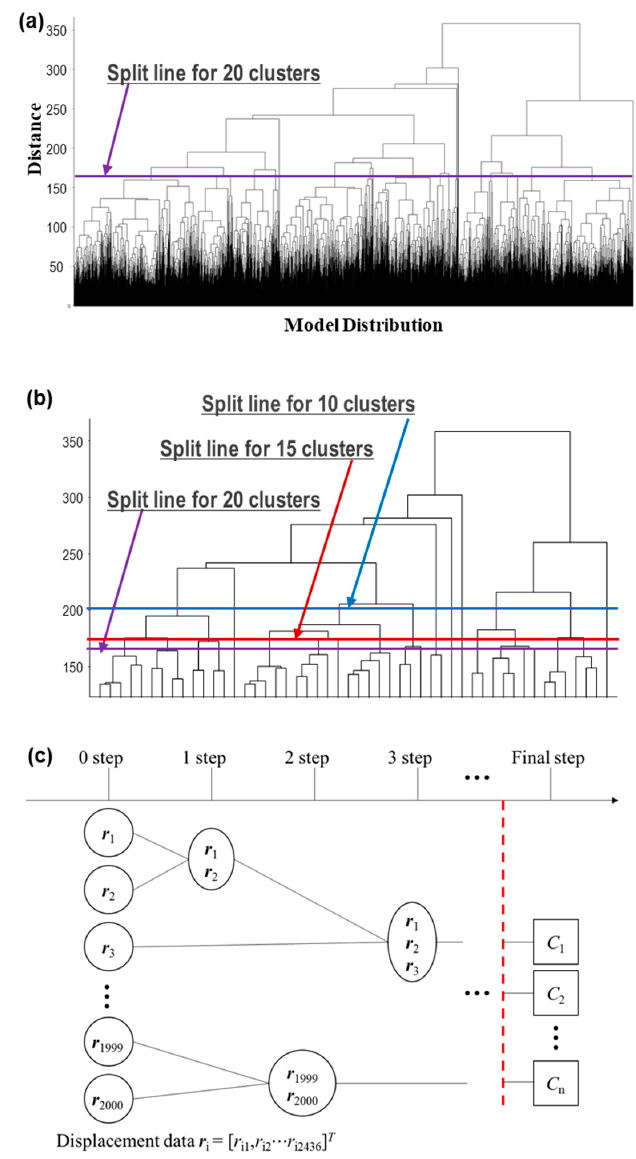
Figure 3. ( a ) A cluster hierarchy (dendrogram) of 2000 BIW models, ( b ) split lines for the three cases of clustering (10, 15, and 20), and ( c ) simple diagram of the hierarchical clustering procedure.